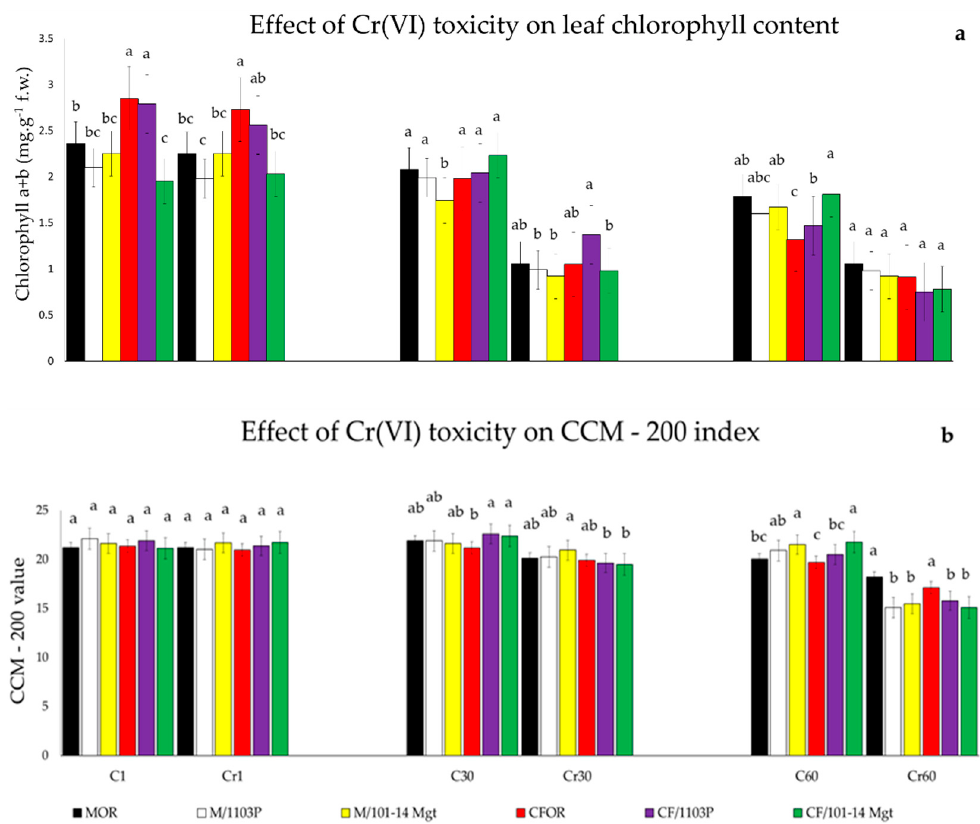
Figure 3. Leaf chlorophyll content ( a ) and CCM-200 chlorophyll index ( b ) at 1st, 30th, and 60th days after the beginning of Cr(VI) treatment in own-rooted (OR) Merlot (M) and Cabernet Franc (CF) vine varieties or vines grafted to 1103P and 101-14 Mgt rootstocks. C: control; Cr: Cr(VI) treatment; 1,30,60: at days one, thirty, and sixty respectively. Chl a+b (F:23.191). CCM-200 (F: 10.319). Different letters represent significant difference of p < 0.05.